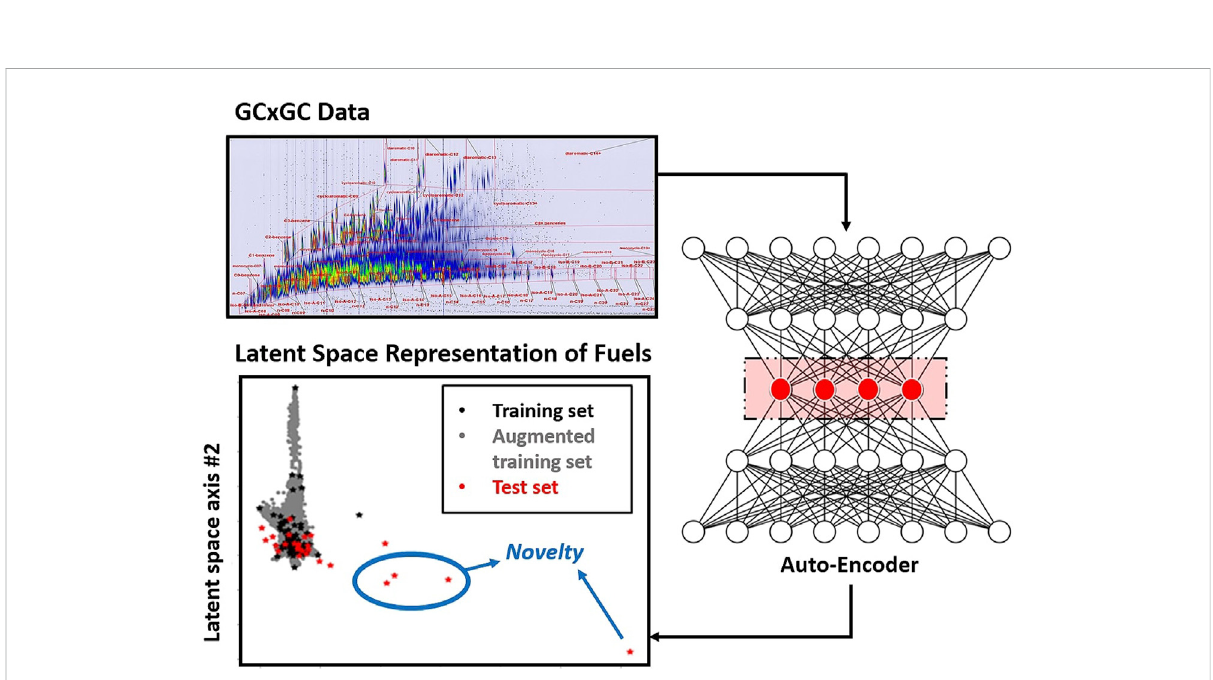
FIGURE 5 Deepautoencoders(lowerleft)usedtodetect noveltycompositionsfromGCxGC(upperleft);aproposeddeep-learning-based frameworkfor screening SAF